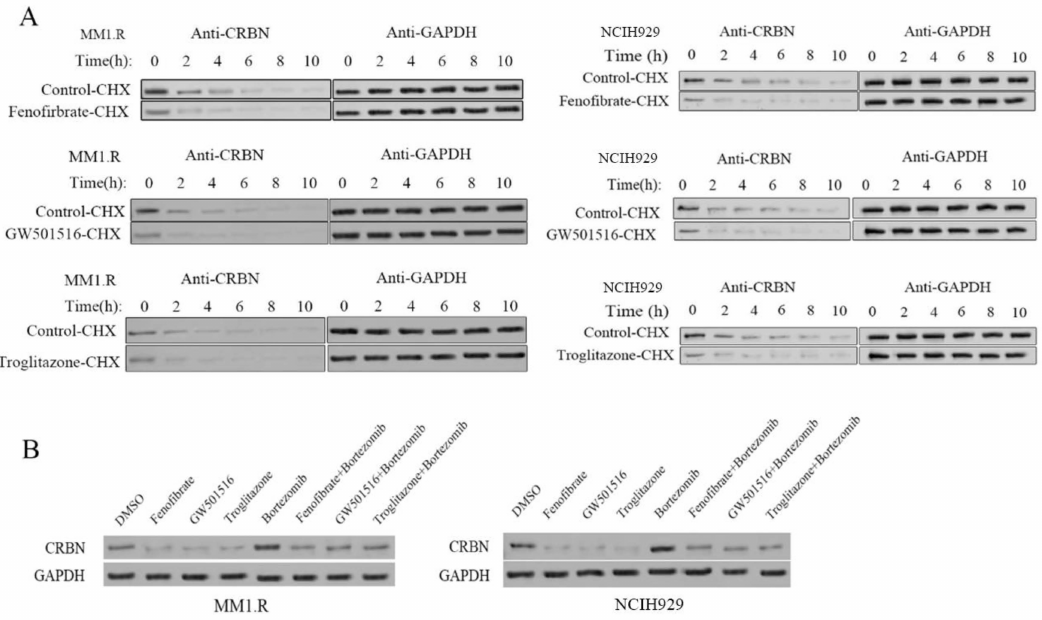
Figure 3. CRBN is rapidly degraded in the presence of PPAR agonists. ( A ) MM1.R and NCIH929 cells were treated with 5 µ M Fenofibrate, GW501516 and Troglitazone. The protein degradation of CRBN was assessed following treatment with 100 µ g/mL cycloheximide (CHX) for 0–10 h; ( B ) Proteasome inhibitor (bortezomib) prevented the degradation of CRBN by PPAR agonists. MM1.R and NCIH929 cells were treated with DMSO control, bortezomib (50 nM) for 1 h, followed by treated with DMSO or 5 µ M Fenofibrate, GW501516 and Troglitazone for an additional 6 h. Whole cell lysate was prepared and analyzed for CRBN expression by Western blot analysis. Data were representative of 2 separate sets of experiments. The uncropped blots are shown in Figure